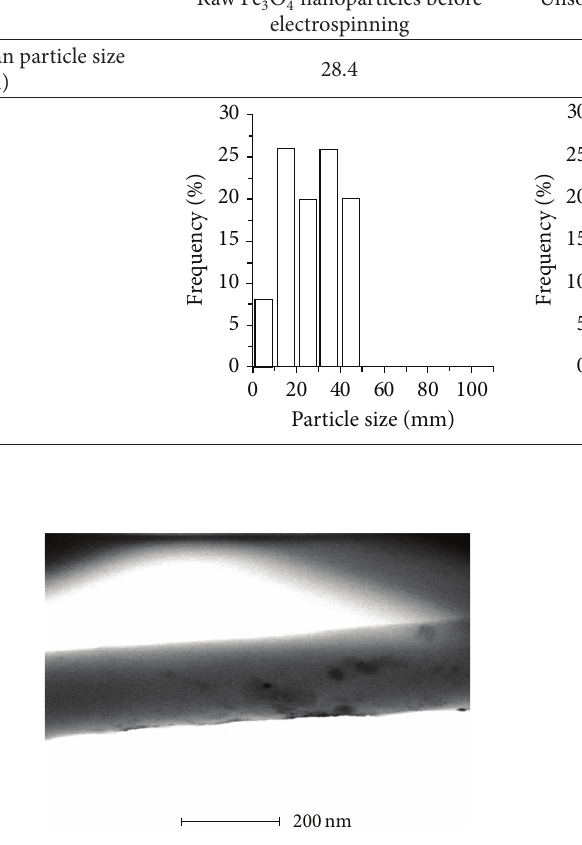
Figure 3: Dispersion of Fe 3 O 4 nanoparticles inside a fibre after sonication (60min).